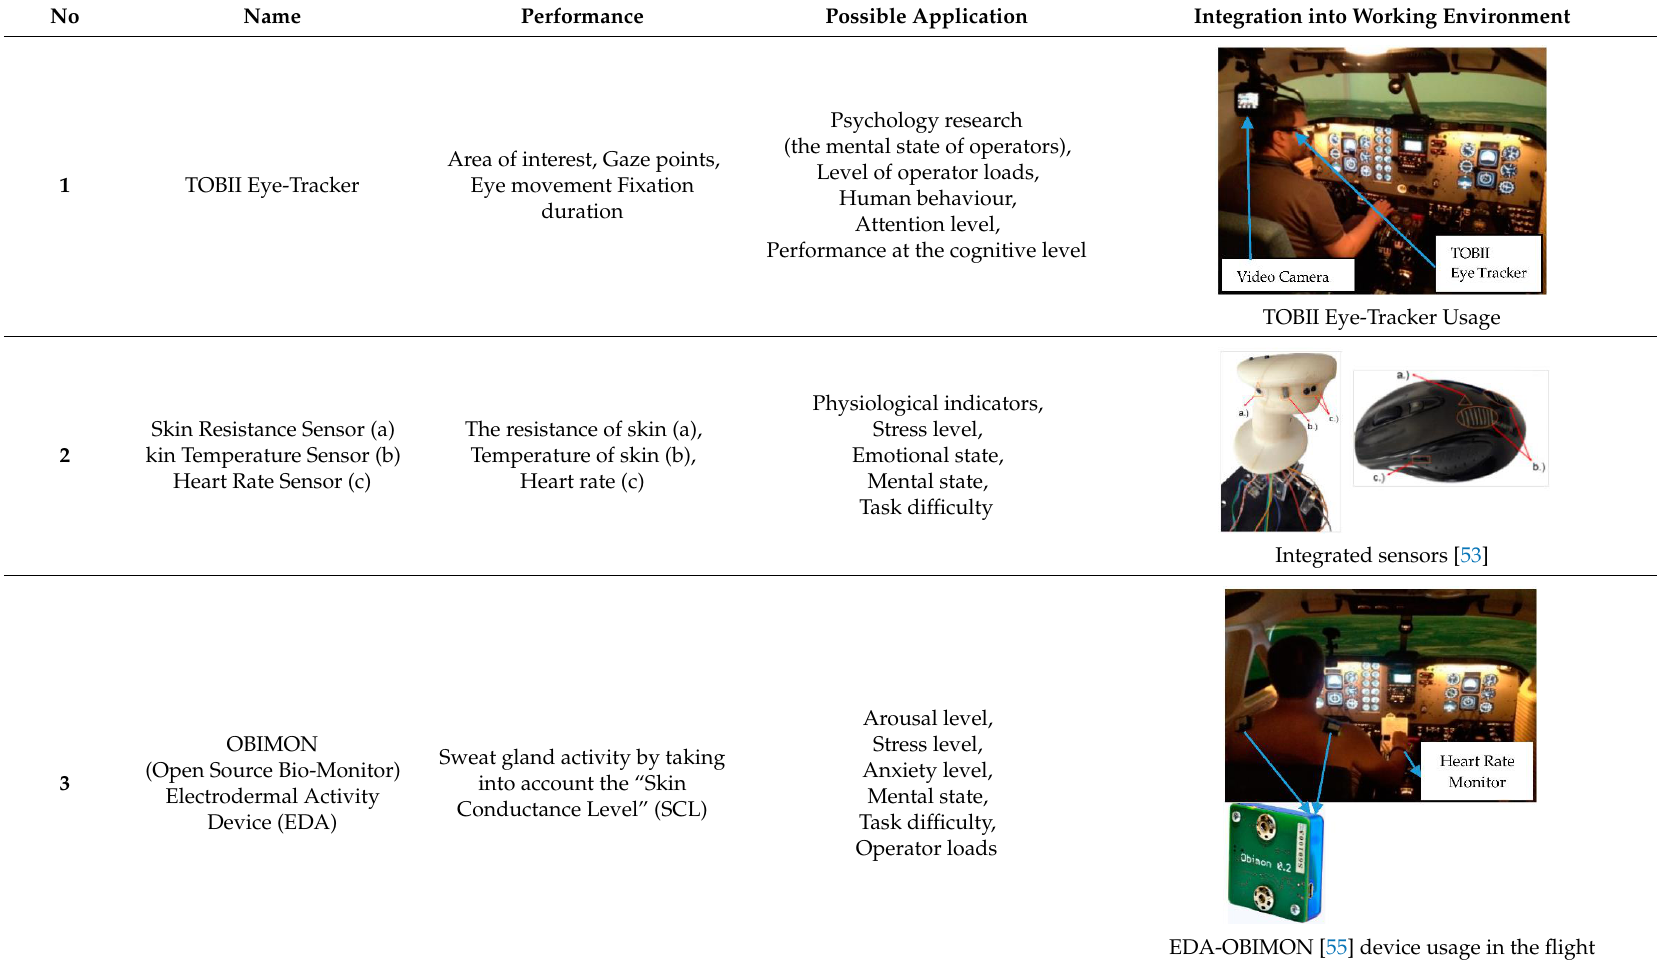
Table 1. Possible sensors and their application.